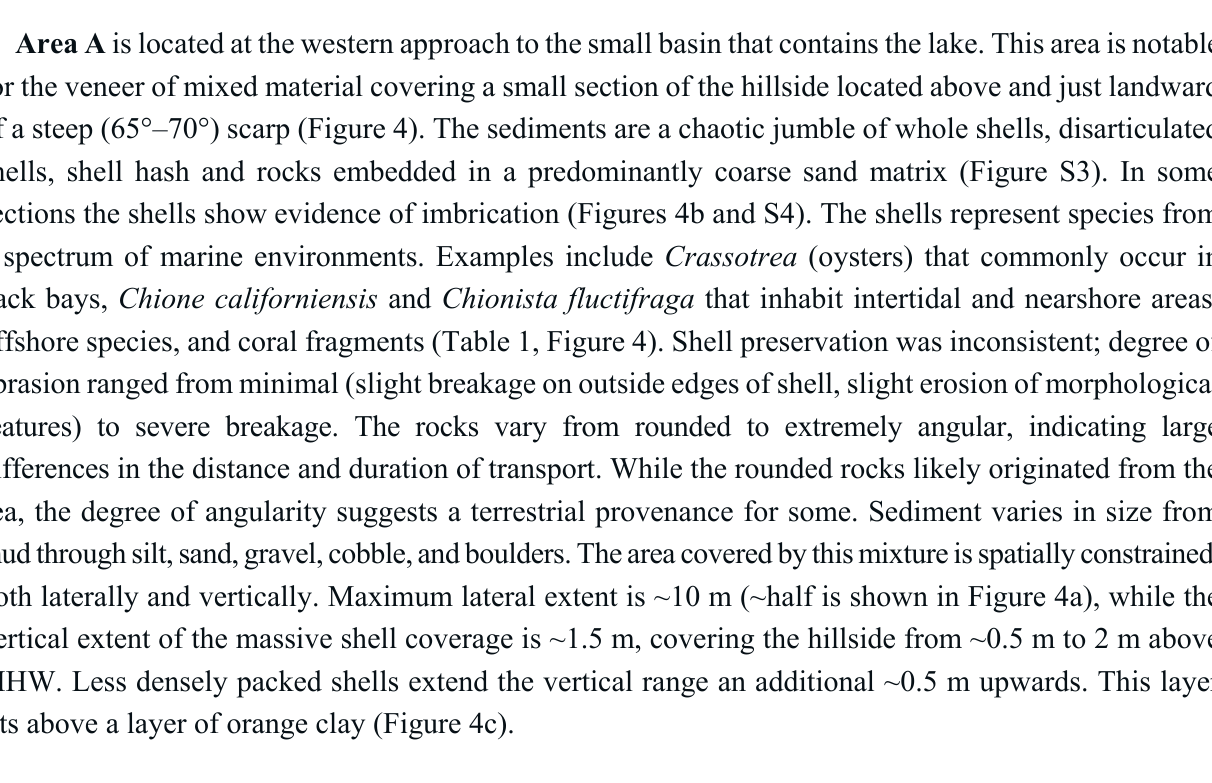
Table 1. Name, geographic range and radiocarbon and calibrated dates for identified shells. Shell Information Dating